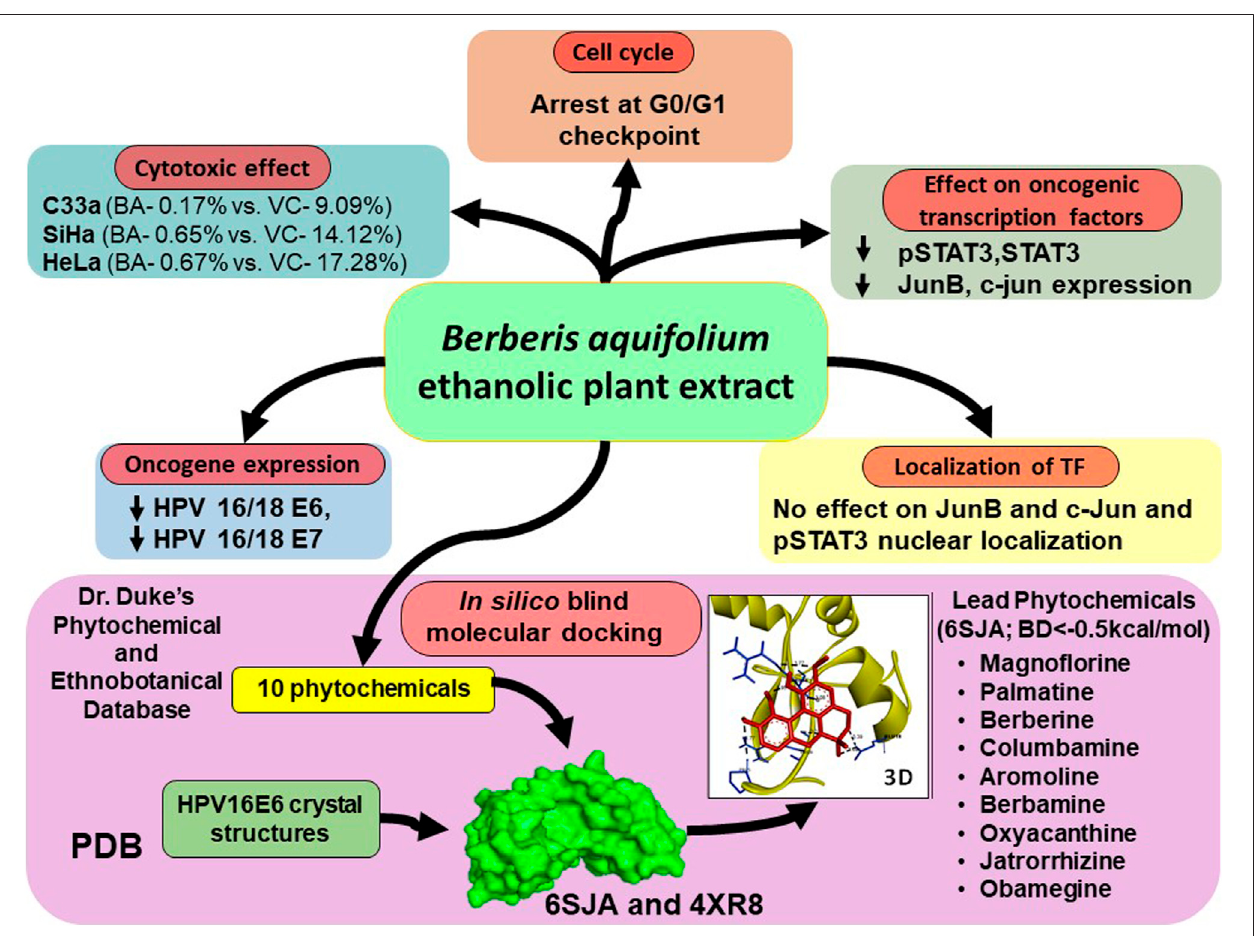
FIGURE 7 | Schematic representation of multifactorial action of BAMT on CaCx cells.